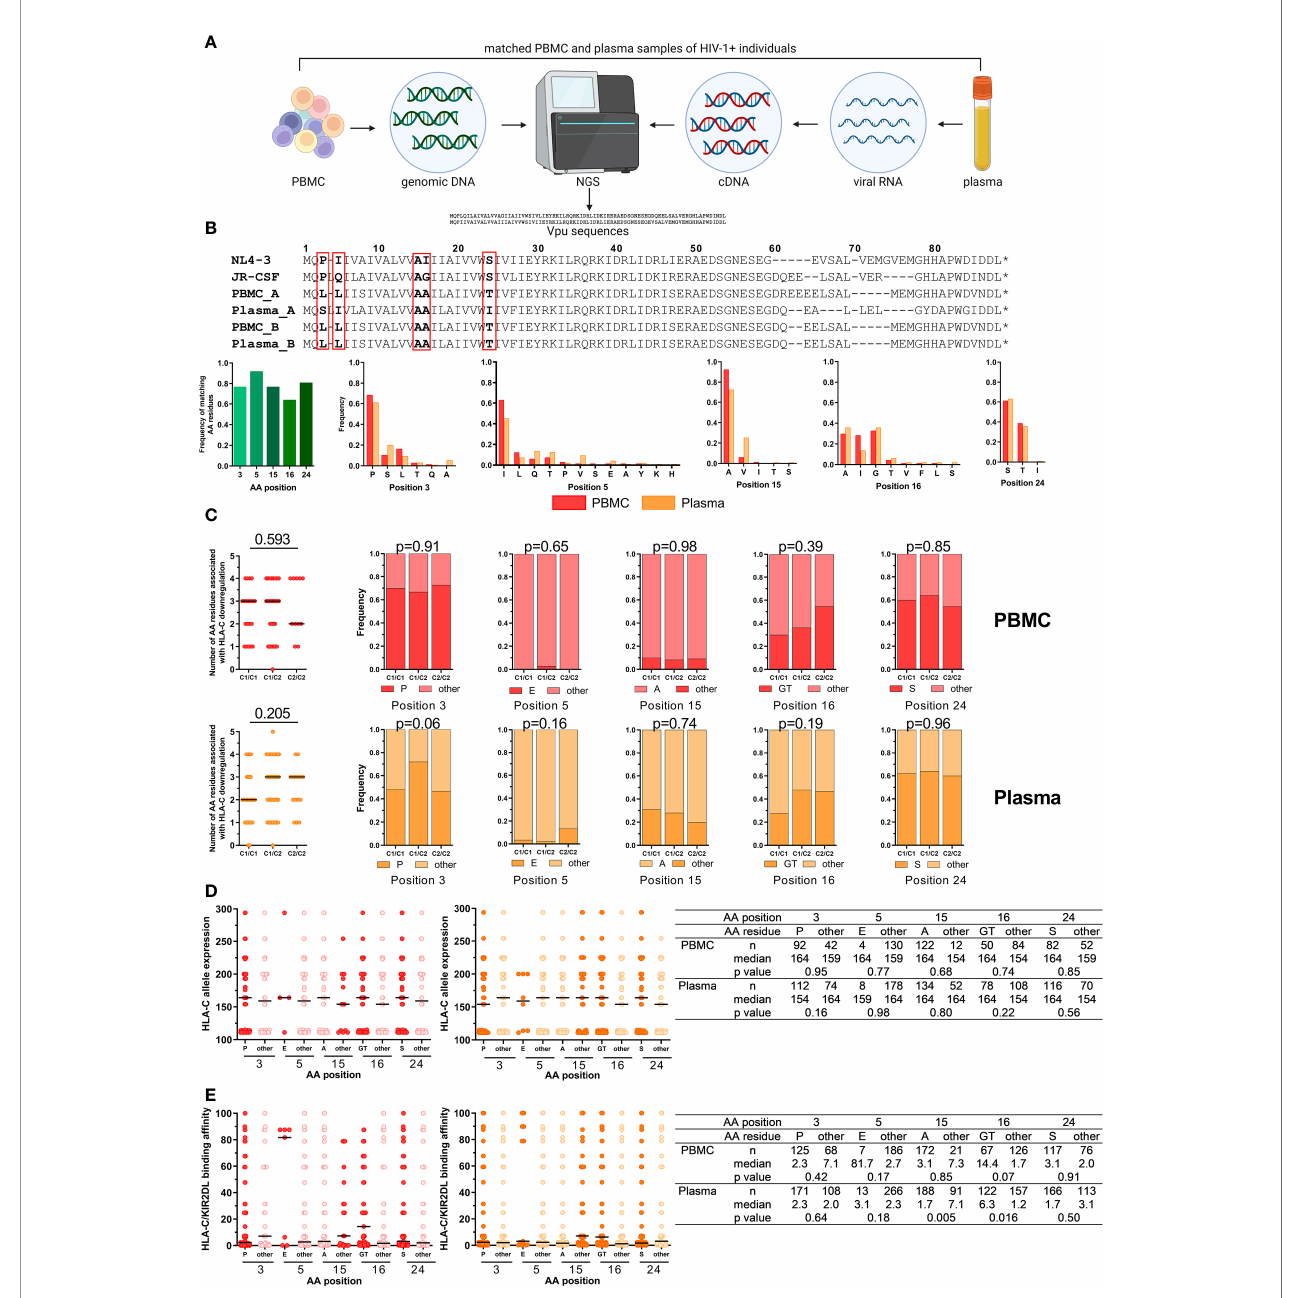
FIGURE 4 | Impact of HLA-C/KIR2DL genotypes on Vpu sequence polymorphisms. (A) Overview of the work fl ow for Vpu sequencing from matched PBMC (n = 122) and plasma samples (n = 122) of untreated HIV-1 + individuals. Created with BioRender.com (B) Upper panel: Representative alignment of amino acid (AA) sequences of HIV-1 Vpu passing quality control. Lower panels: Frequency of matching AA residues at position 3, 5, 15, 16 and 24 between matched PBMC and plasma samples (n = 53). Frequency of individual AA residues at 3, 5, 15, 16 and 24 in PBMC (n = 67) and plasma (n = 93) samples. (C) Left: Dot plots displaying the cumulative number of AA residues associated with Vpu-mediated HLA-C downregulation per sequence. Right: Frequency of AA residues at position 3, 5, 15, 16 and 24. Individuals were strati fi ed by HLA-C group genotypes (x-axis). Upper panel: PBMC, lower panel: Plasma. (D) Expression levels of HLA-C alleles of HIV- 1 + donors. Data points are displayed for each position (3, 5, 15, 16 and 24) and AA residues. AA residues associated with HLA-C downregulation are displayed in red (PBMC, left panel) or dark orange (plasma, right panel). Summary table displaying descriptive and comparative statistics. (E) Binding af fi nities of KIR/HLA-C combinations of HIV-1 + donors. Data points are displayed in red (PBMC, left panel) or dark orange (plasma, right panel). Summary table displaying descriptive and comparative statistics. Data information: Black bars display the median. (C) Left panel: One-way ANOVA, test for linear trend. Right panels: Chi square test. (D, E) Mann-Whitney